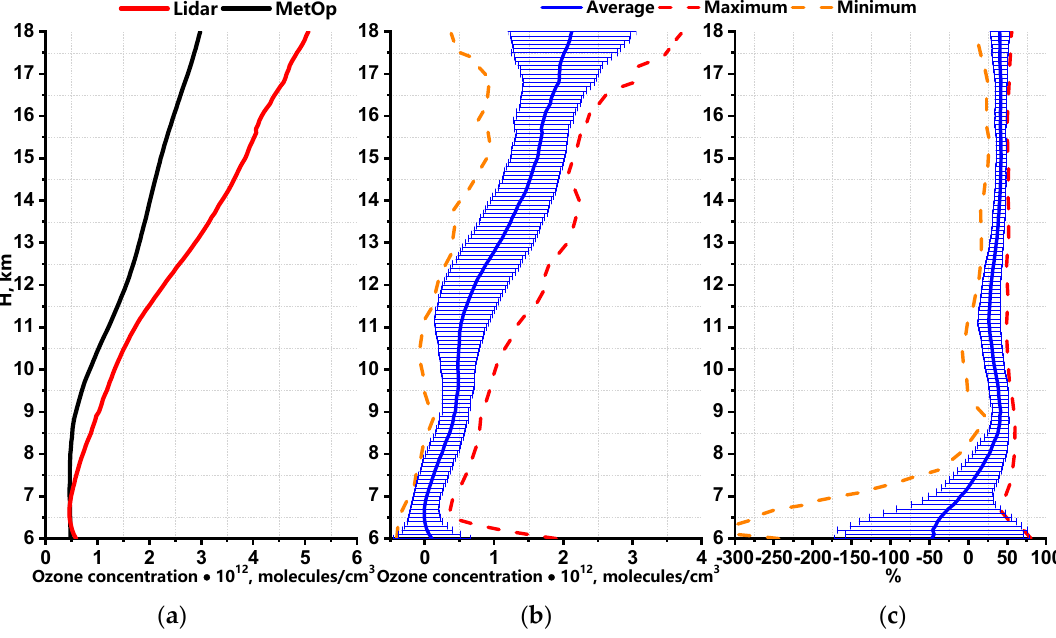
Figure 8. Average OVDs for season of winter–spring and their differences: ( a ) average profiles; ( b ) differences between the lidar and MetOp data, in absolute units; and ( c ) relative differences 100 × (lidar − MetOp )/lidar.